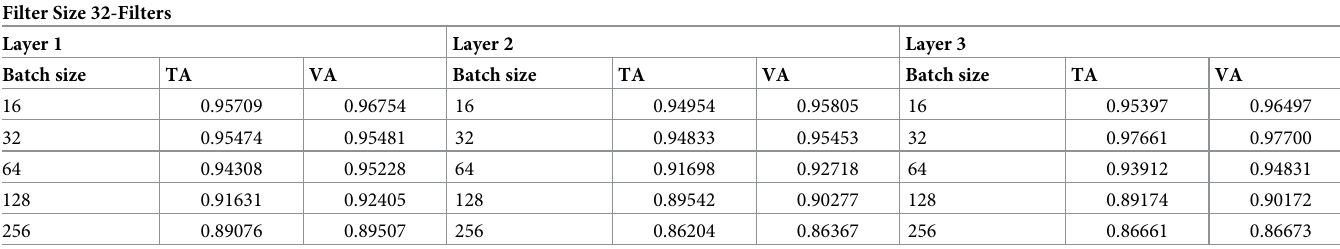
Table 1. Experimentation results of ConvLSTM with